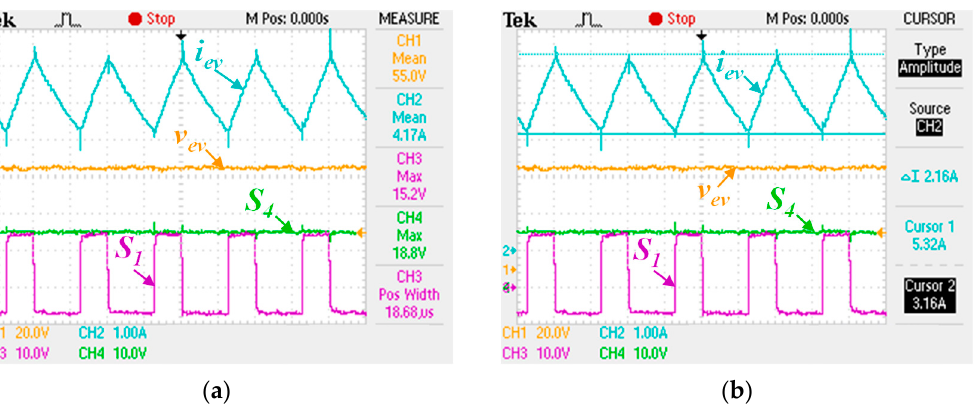
Figure 16. Steady-state operation of the multilevel dc–dc converter following a failure in the neutral wire of the bipolar dc grid: ( a ) an i ev of 4 A and a v ev of 55 V; ( b ) an i ev ripple value of 2.16 A and a duty cycle of 38% for S 1 , while that of S 4 is equal to 100%.